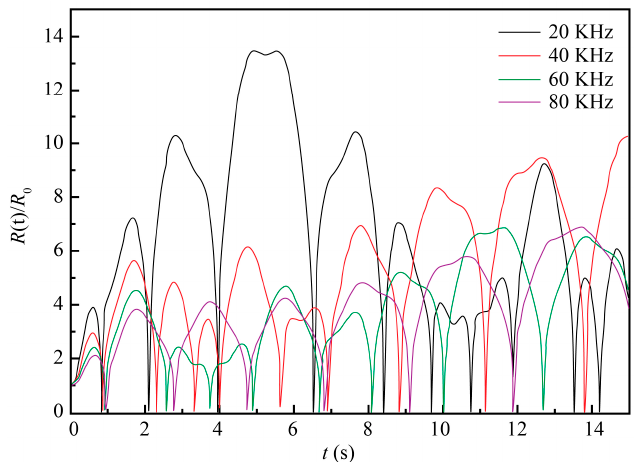
Figure 3. Evolution of cavitation bubble oscillation amplitude at four different frequencies and constant ultrasound pressure amplitude ( P f ) = 0.2 MPa.